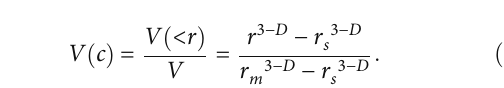
sublayer of Yanchang Formation study area, Ordos 3